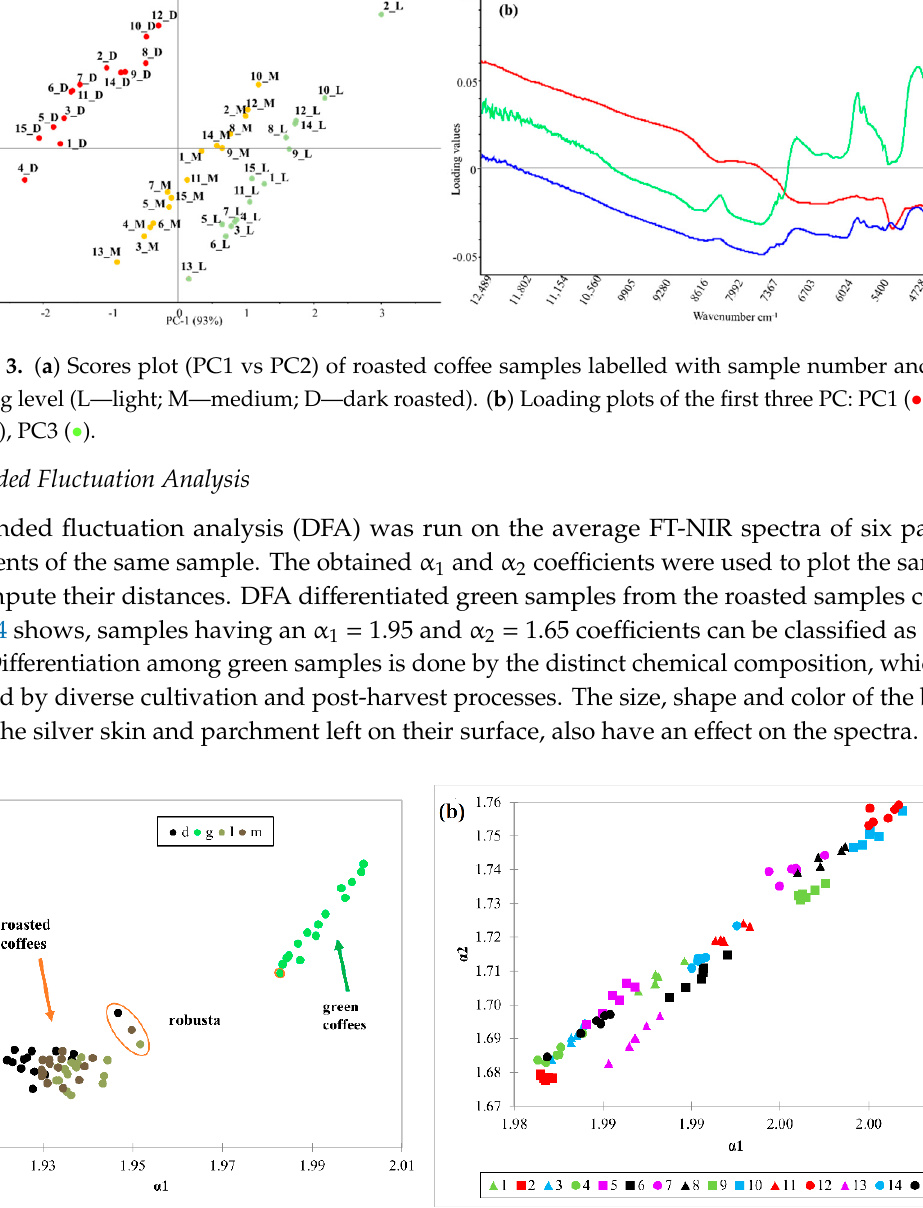
Figure 4. α 1 and α 2 coefficients obtained from detrended fluctuation analysis. A ) averaged spectra of the green (g), light (l), medium (m) and dark roast (d) samples. Different colors denote different roasting levels B ) the six replicates of the green samples. Different colors and symbols denote different countries.